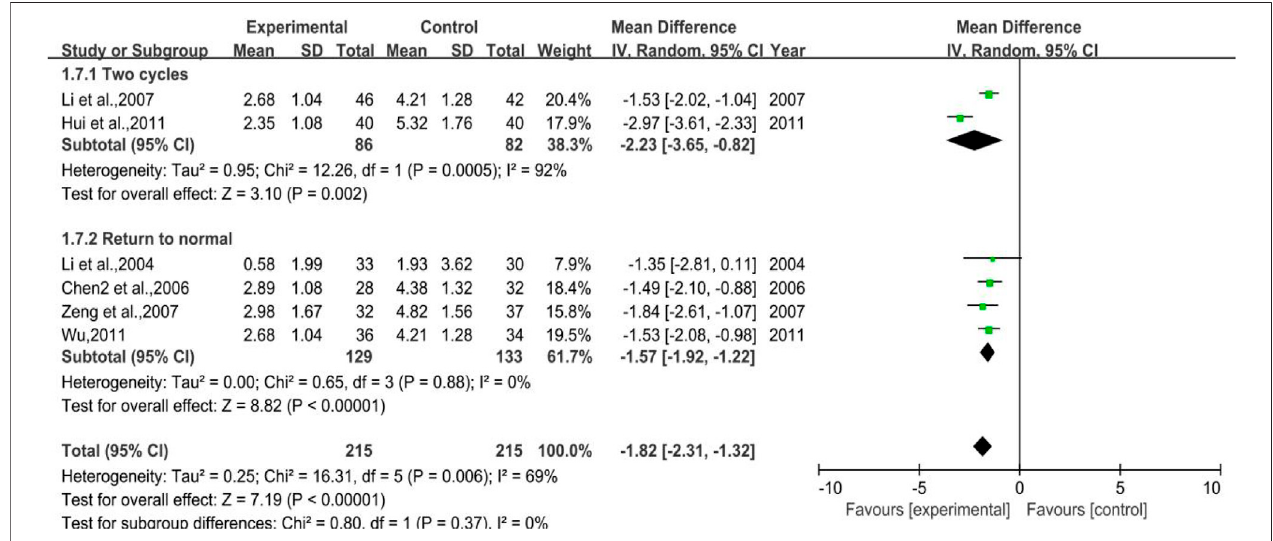
FIGURE 9 | The forest plot of the application amount of G-CSF in preventive medication.